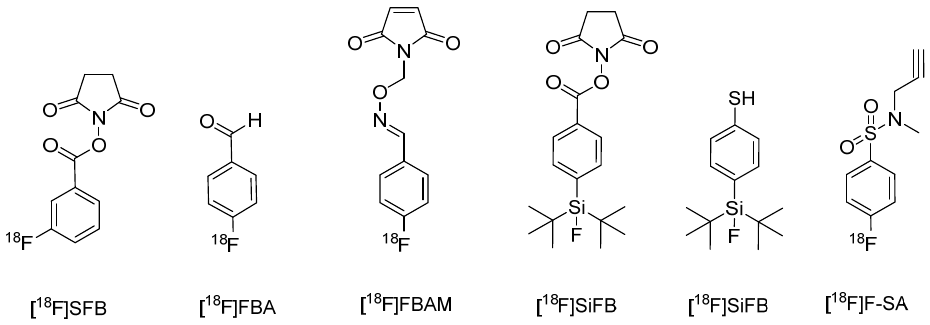
Figure 5. Structures of prosthetic groups used to indirectly incorporate 18 F